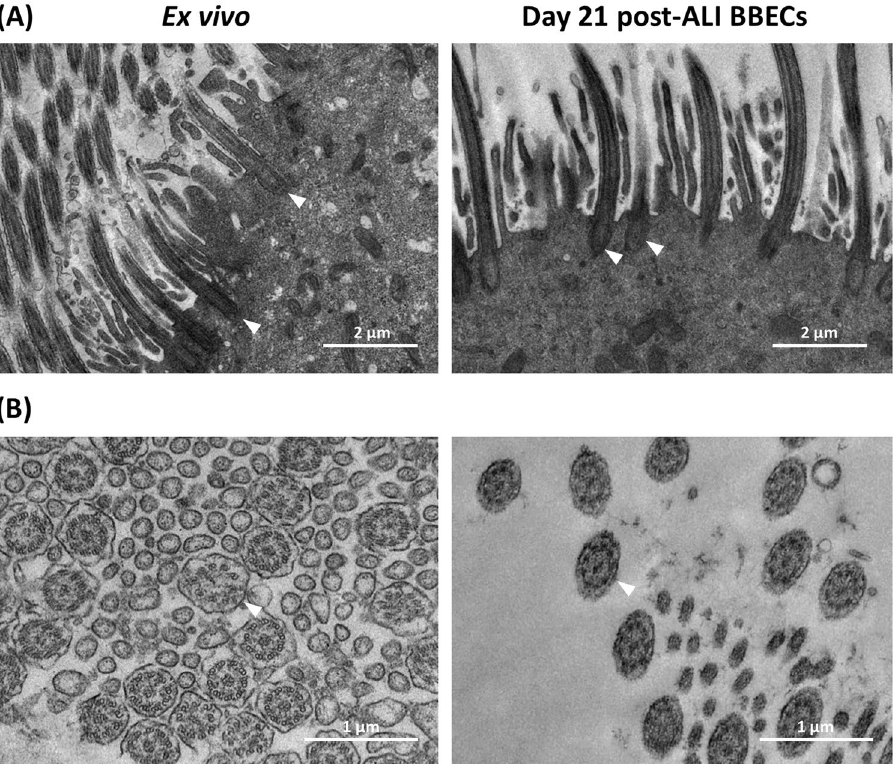
Figure 7. Ultra-structural comparison of cilia formation in ex vivo bronchial epithelium and differentiated BBECs using TEM. Ex vivo bronchial epithelium and day 21 post-ALI BBEC cultures were fixed and resin embedded, and ultrathin sections were cut and contrast stained. Comparisons are made of ( A ) longitudinal sections of cilia and basal bodies (arrowheads) and ( B ) transverse sections of cilia showing 9 + 2 axoneme arrangement